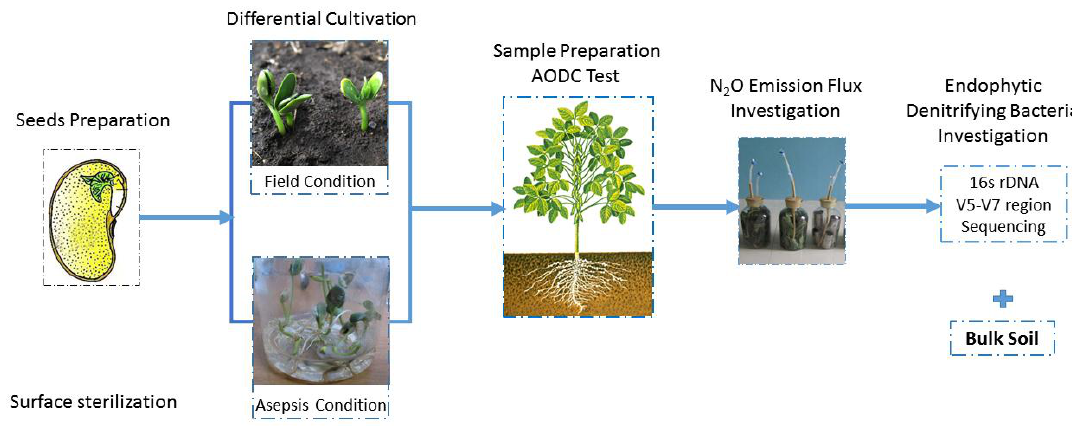
Figure 1. The work flow of this study.